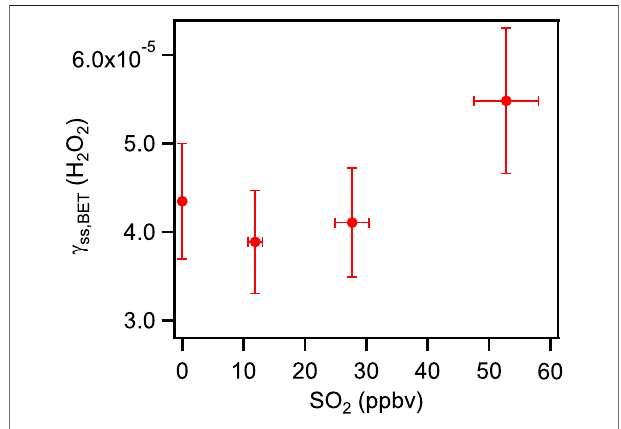
FIGURE4| Dependenceofthesteadystate uptakecoef fi cients ofH 2 O 2 on different mixing ratios of SO 2 .